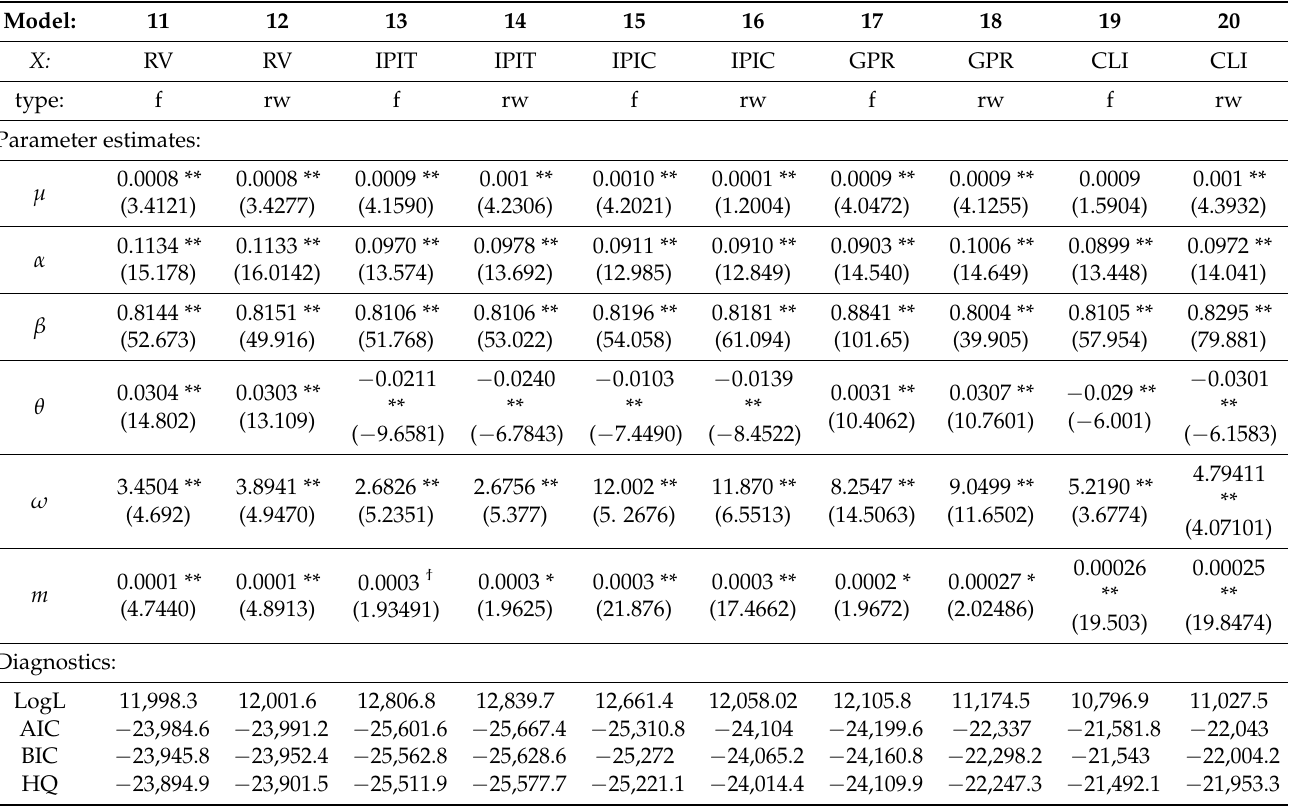
Table 5. GARCH-MIDAS-LSTM Estimation Results.